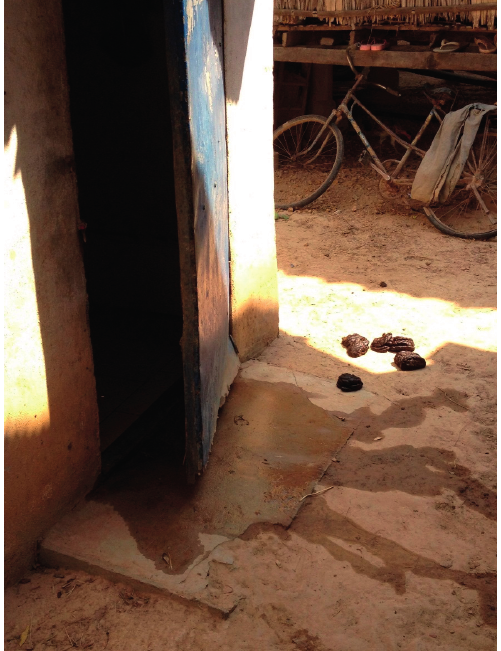
Figure 3. Animal feces around the home